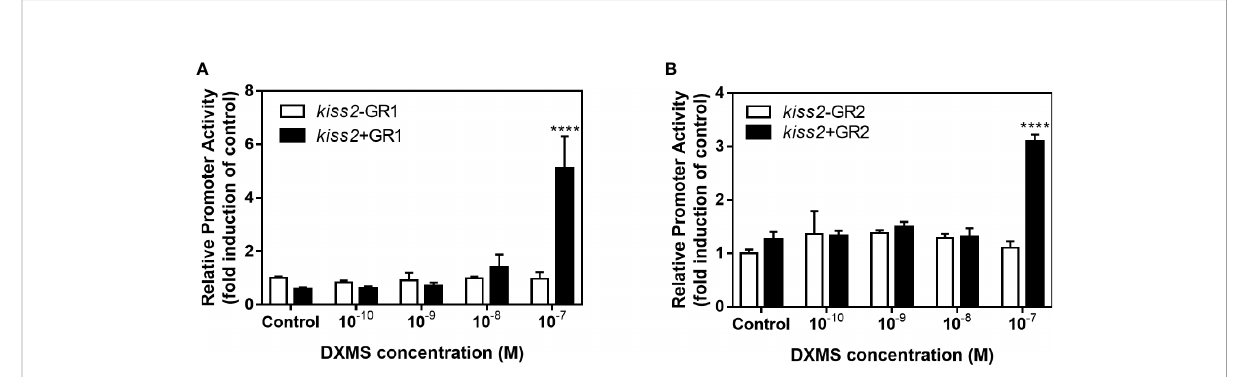
FIGURE 6 Effects of cortisol with different concentrations on the activities of kiss2 gene promoter. HEK-293T cells were transfected with 0.5 m g pkiss2- 1442, 0.05 m g GR1 (A) or GR2 (B) and 0.025 m g pRL-CMV; 0.5 m g pGL4.10 co-transfected with 0.025 m g pRL-CMV as the control. Cells were treated with or without cortisol. Luciferase activity was detected after 24 h. Data are represented as mean ± SEM (n = 4). **** (p < 0.0001) indicates signi fi cant differences between groups with cortisol treatment.